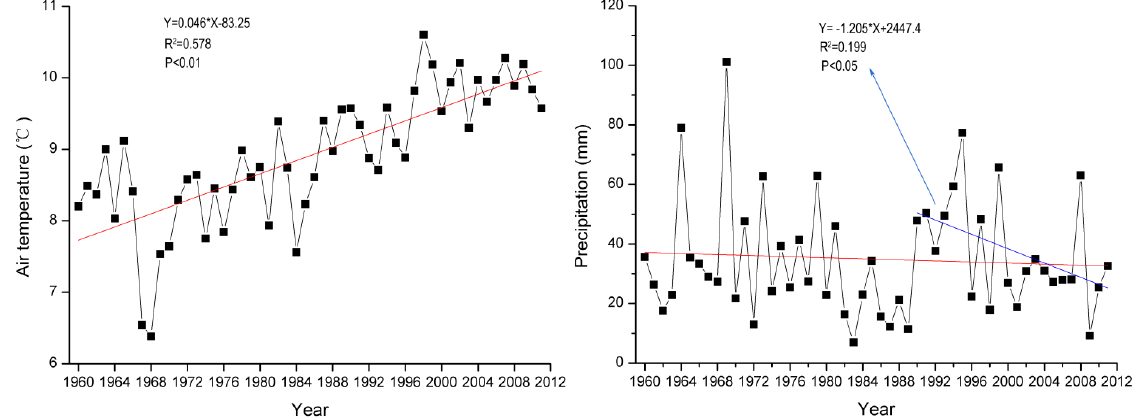
Figure 8. Trends in annual temperature and annual precipitation in the Ejin Oasis between 1960 and 2011. The red line denotes trends in temperature and precipitation changes between 1960 and 2011, respectively. The blue line denotes trends in precipitation changes between 1990 and